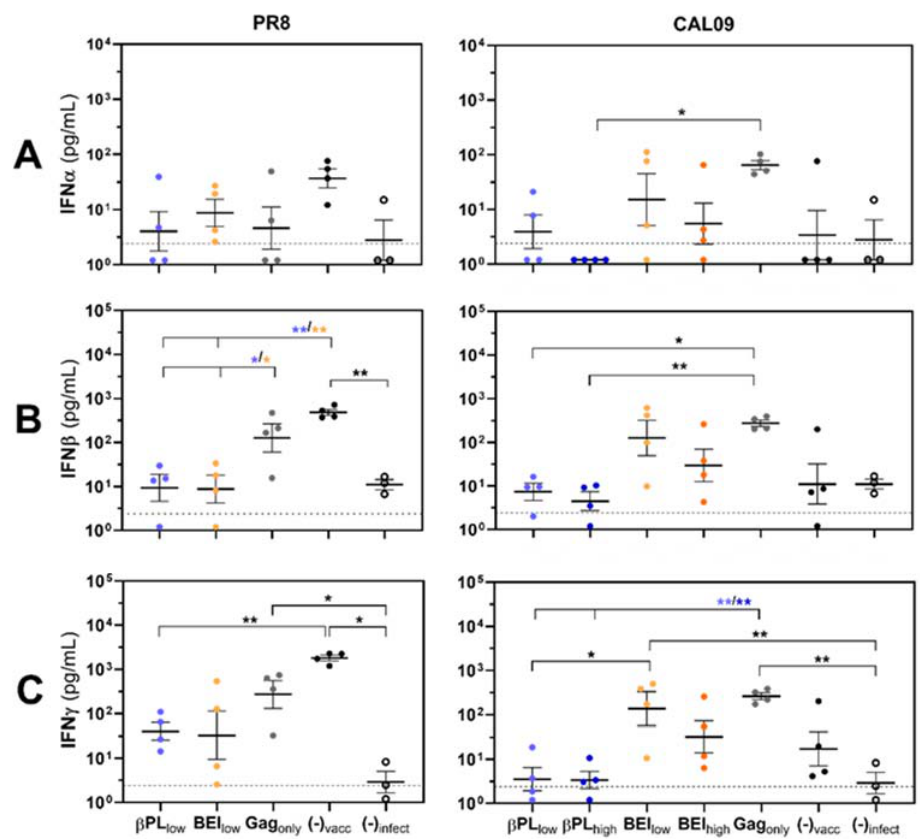
Figure 3. E ff ective anti-HA immunity suppresses influenza-mediated IFN type I / II responses in the lungs of infected mice. Lung homogenates from immunized or mock-vaccinated mice ( n = 4 per group) infected with vaccine-matched PR8 (left panel) or non-matched CAL09 (right panel) were analyzed for the expression of ( A ) IFN α , ( B ) IFN β , and ( C ) IFN γ four days post-viral infection. Basal type I / II IFN expression levels were analyzed in naïve, non-infected mice ( n = 3). Symbols represent the mean IFN concentration of a duplicate measurement from a single mouse and lines and error bars indicate group means +/ − SEM. Color code vaccine groups: β PL low (light blue), β PL high (dark blue), BEI low (light orange), BEI high (dark orange), Gag only (grey), non-vaccinated (black, full circle), naïve (black, open circle). Statistical significance of di ff erences in mean IFN-concentrations between groups was analyzed by One-Way ANOVA and a Tukey posthoc test or by Welch ANOVA followed by a Dunnett‘s T3 posthoc test for multiple comparisons ( C , left panel) on basis of log-transformed data. The dashed line indicates the defined LLOD and represents the lowest analyte concentration of the calibration curve (2.4 pg / mL). Asterisks indicate the significance level giving adjusted p -values for multiple comparisons with * p adj < 0.05 and ** p adj < 0.01.